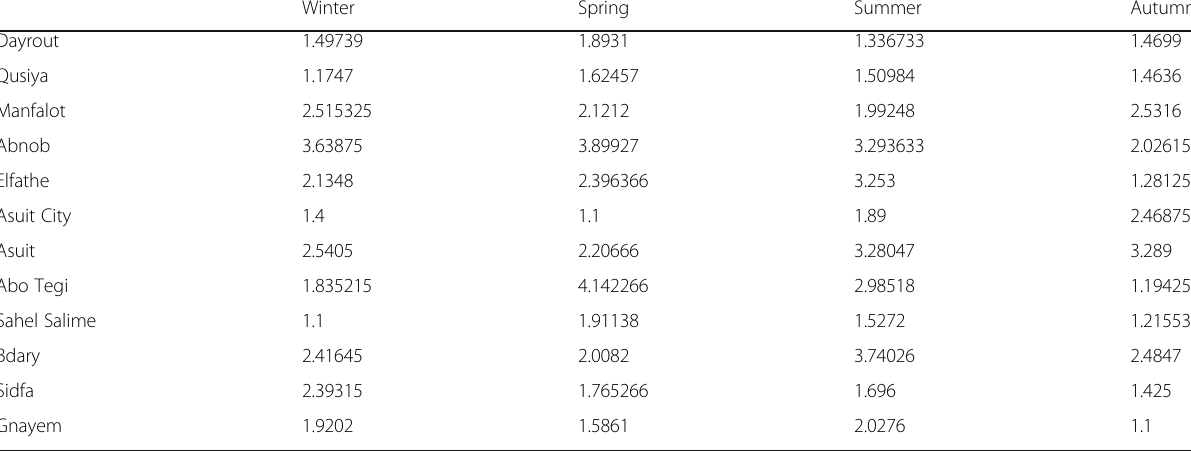
Table 6 Total seasonal coliform (MPN/100 ml) (2017) Winter